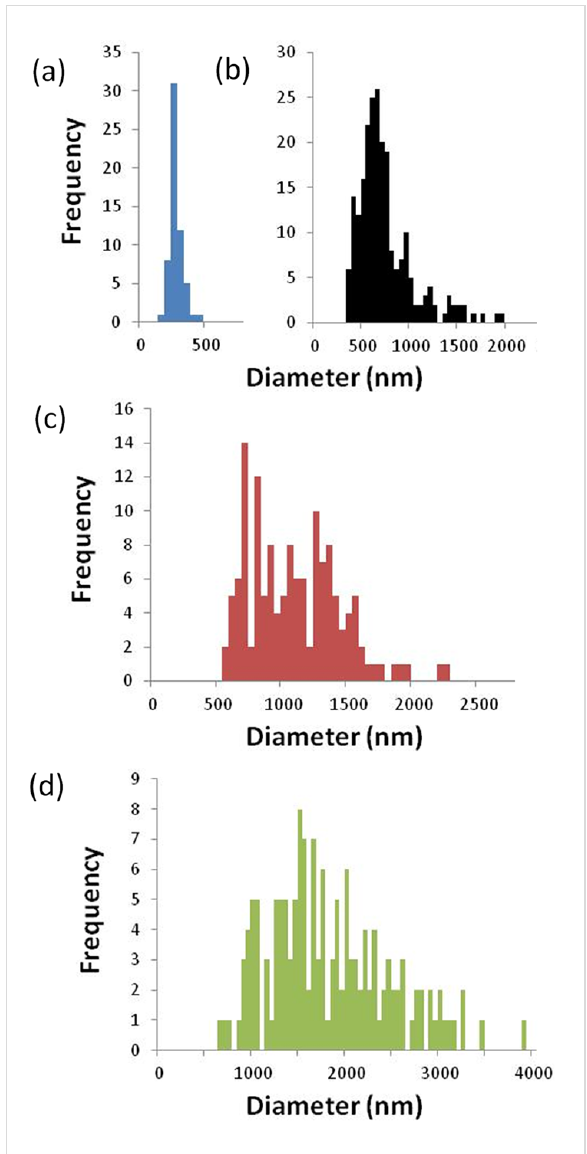
Figure 4: Aggregate diameter distribution of fluorescence microscopy images; 31 μ M galectin-3 and 0.14 μ M (a) 2 , (b) 3 , (c) 4 and (d) 5 .